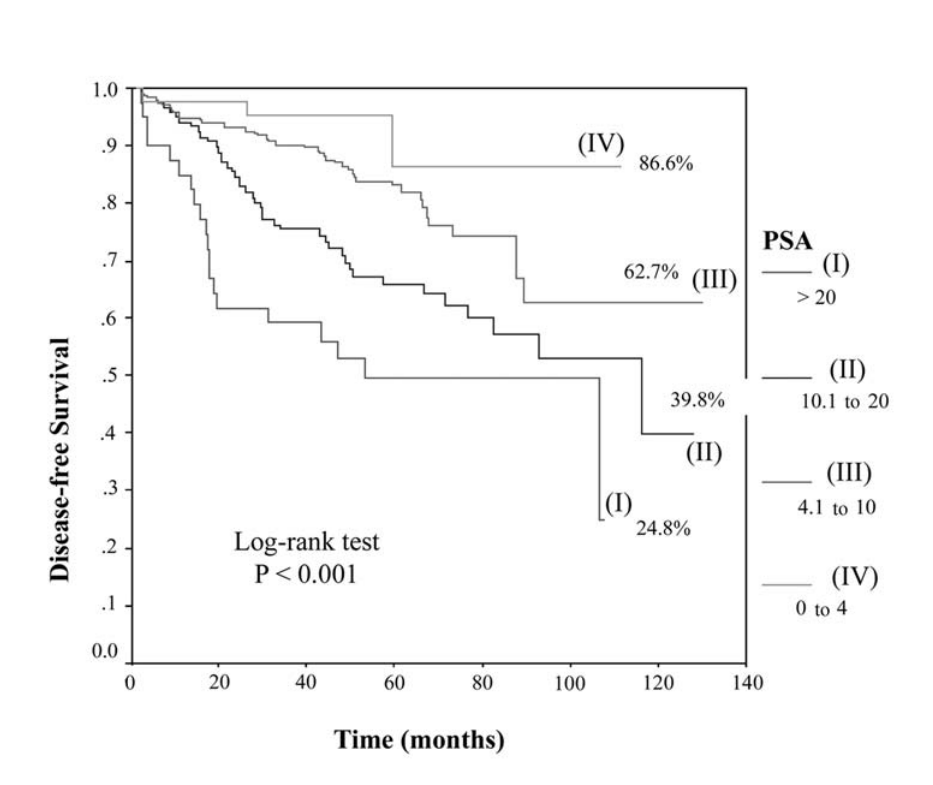
Figure 1 – Survival probability curve for biochemical recurrence of disease according to PSA categories.